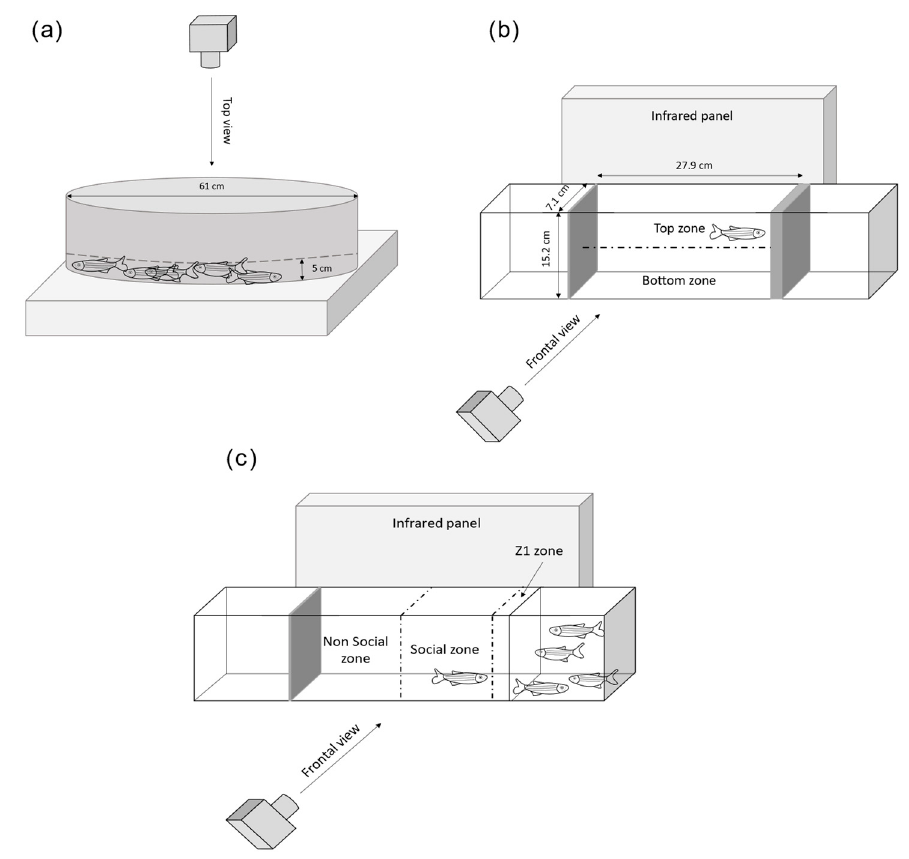
Figure 2. Experimental setup of the three behavioral tests. ( a ) The shoaling test, ( b ) the novel tank test, ( c ) the social preference test